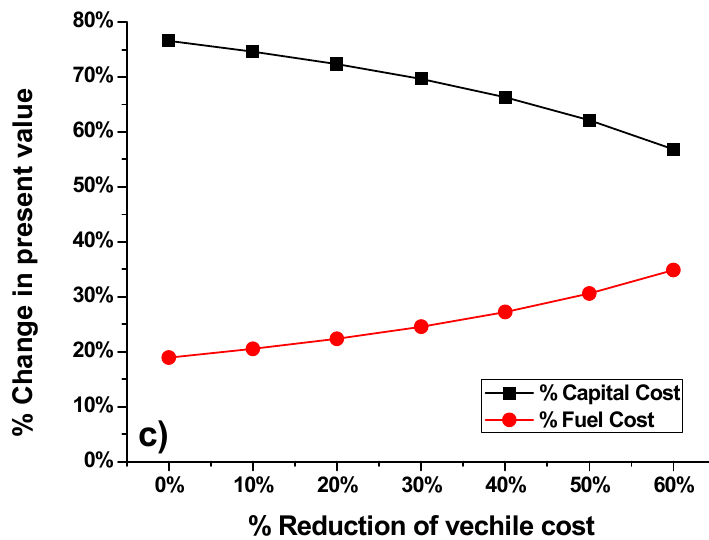
Figure 8. Effect of increasing the capacity factor for hydrogen production to the hydrogen production life cycle cost ( 8a ), effect of increasing the feedstock cost to the hydrogen production life cycle cost ( 8b ) and effect of the vehicle cost reduction on the present value of hydrogen application ( 8c ).